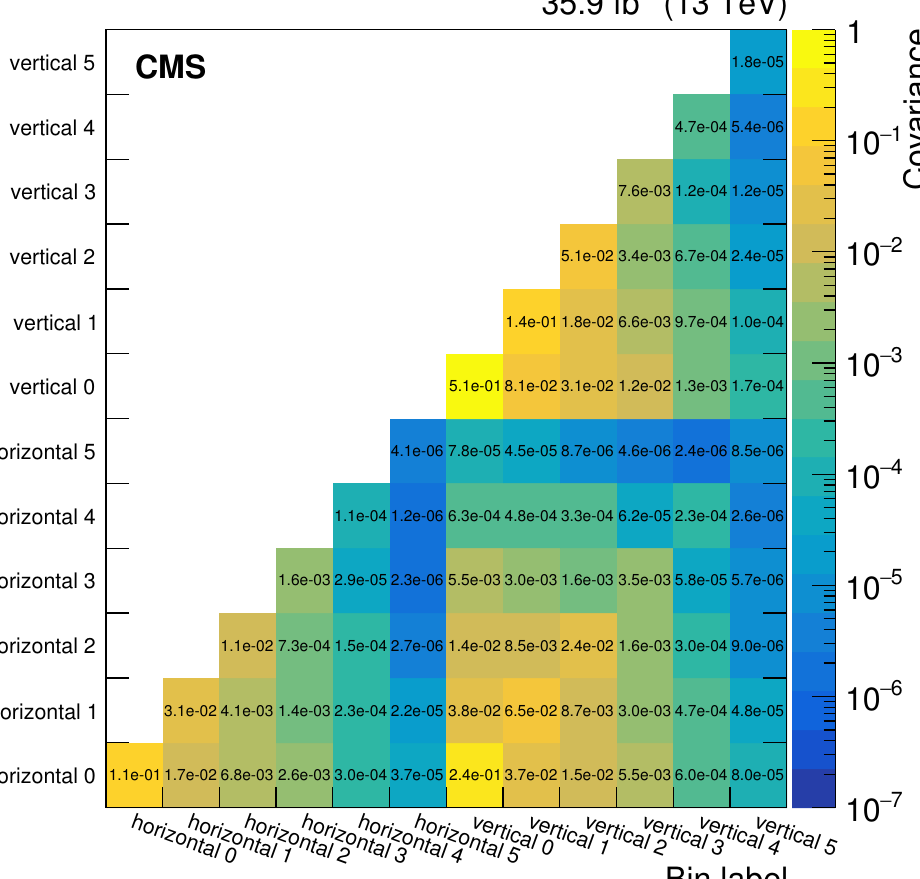
Figure 15 . Covariances between the predicted background yields in all the E (cid:13) and vertical signal regions. The bin labels specify which signal region the bin belongs to and what number bin it is for that